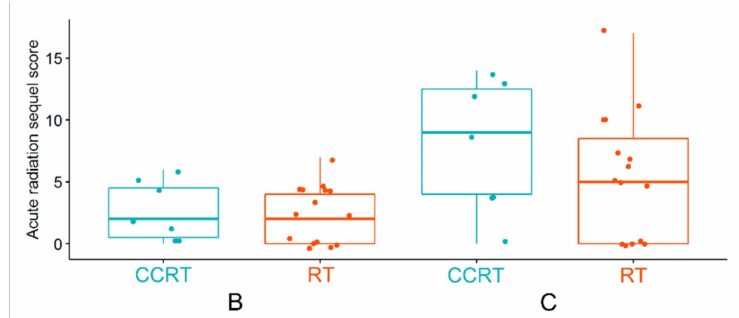
Figure 7. Acute radiation sequel (ARS) estimated based on morphological and functional reactions in patients from RT and CCRT groups during a treatment (time point B) and after the end of treatment (time point